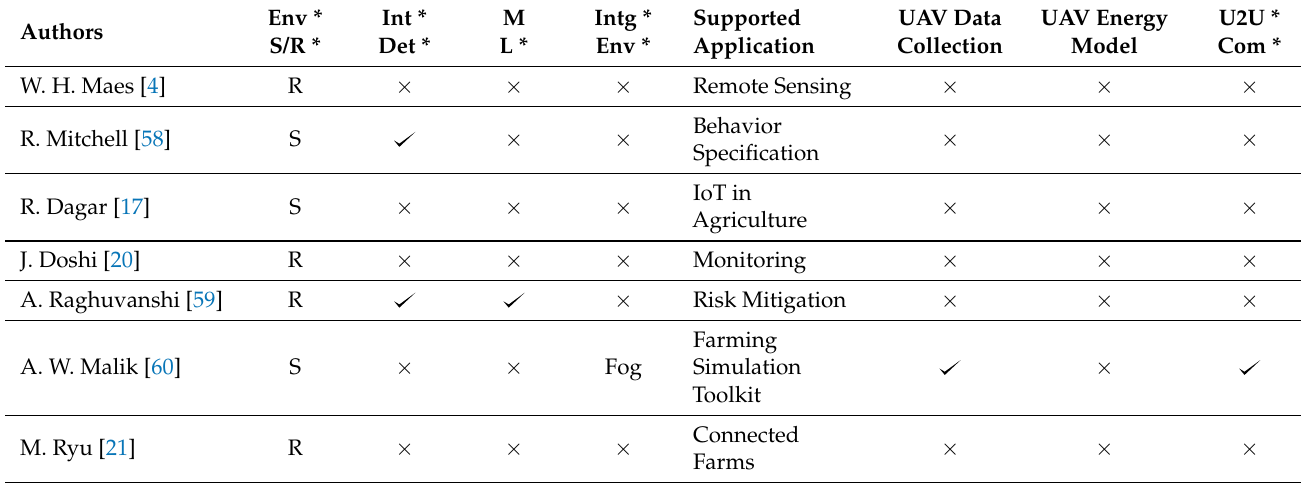
Table 1. Comparison of Related Work in Precision Agriculture and Intrusion